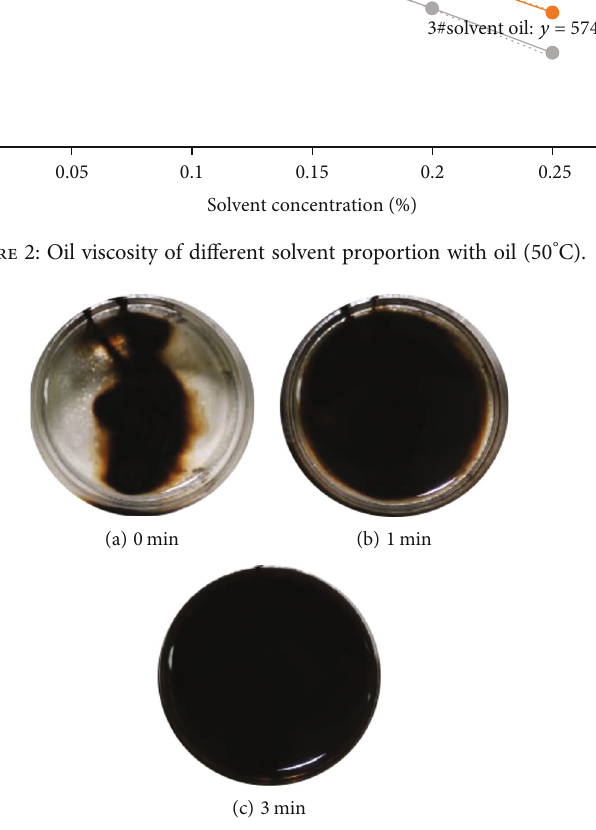
Figure 3: Visualization of oil dissolution process with light hydrocarbon solvent (2# solvent